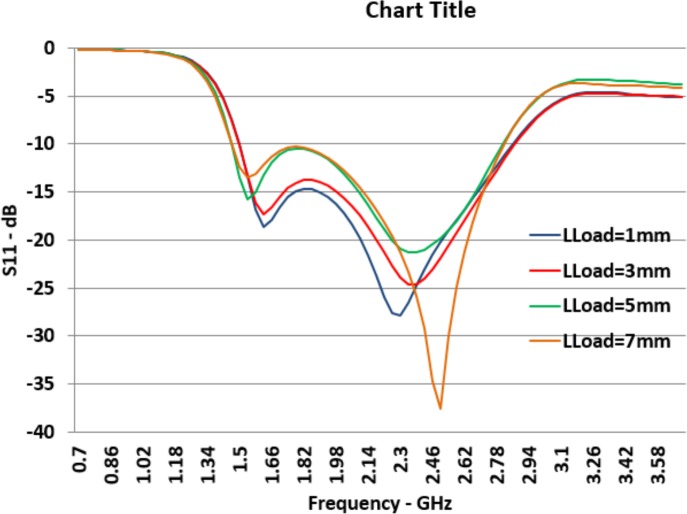
Effects of LLoad Changes on Reflection Coefficient (S11).